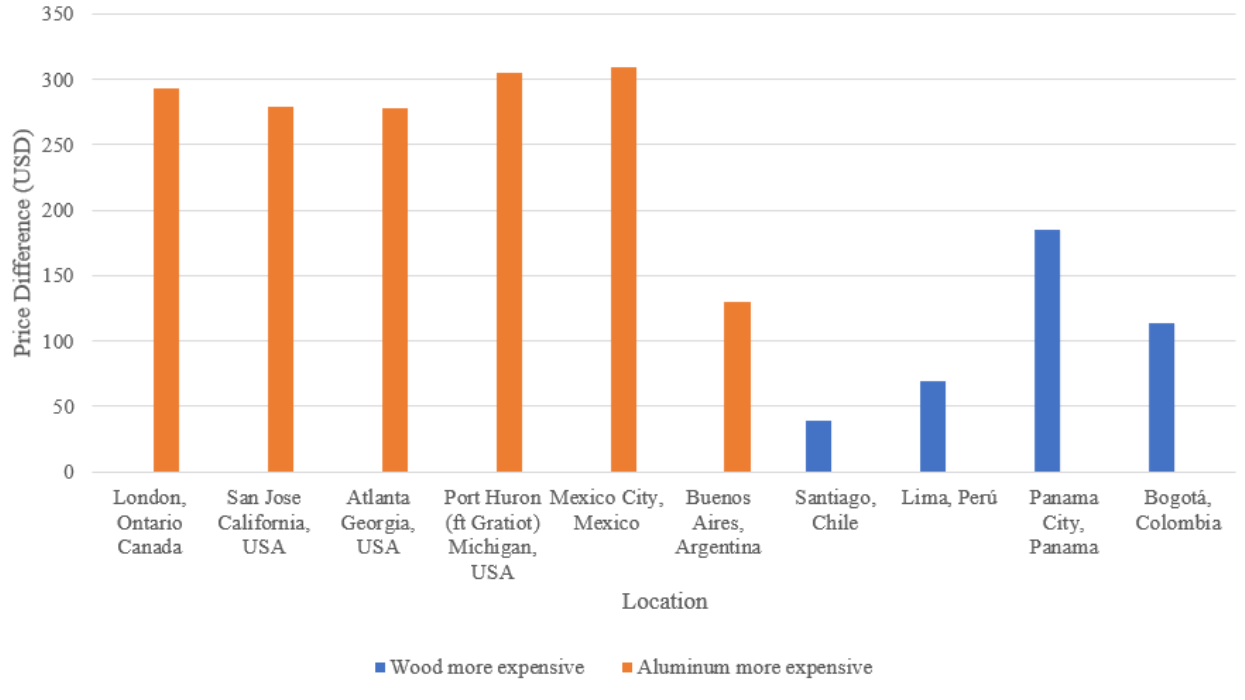
Figure 3. The difference in the capital costs of the open hardware PV based on materials selection in the ten cities/countries as well as the less expensive material denoted by color.